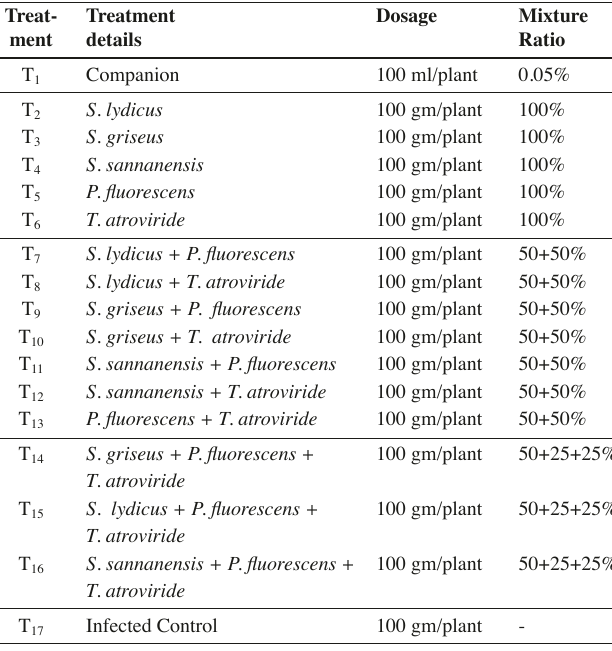
Tab. 1: Treatment details and rates of application of biocontrol agents